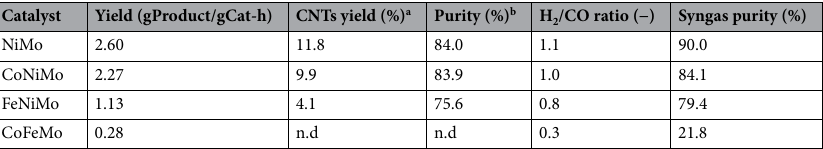
Table 3. Summary of CNTs yield, CNTs purity, H 2 /CO ratio, and Syngas purity with different catalysts. a Calculation based on methane in feedstock. b Analysis by TGA.